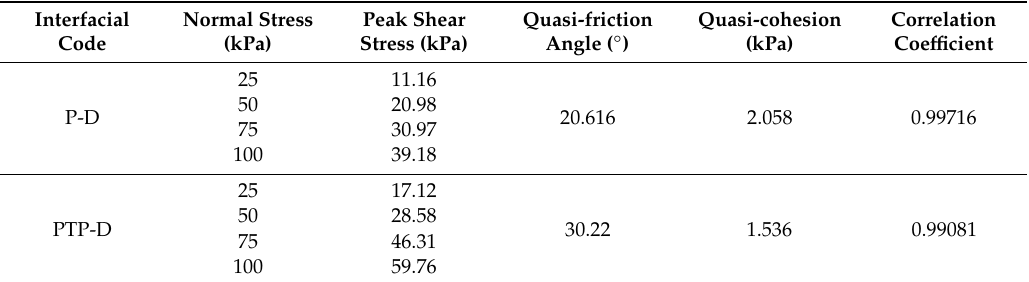
Table 3. Indexes of interfacial shear characteristics of different interfaces.